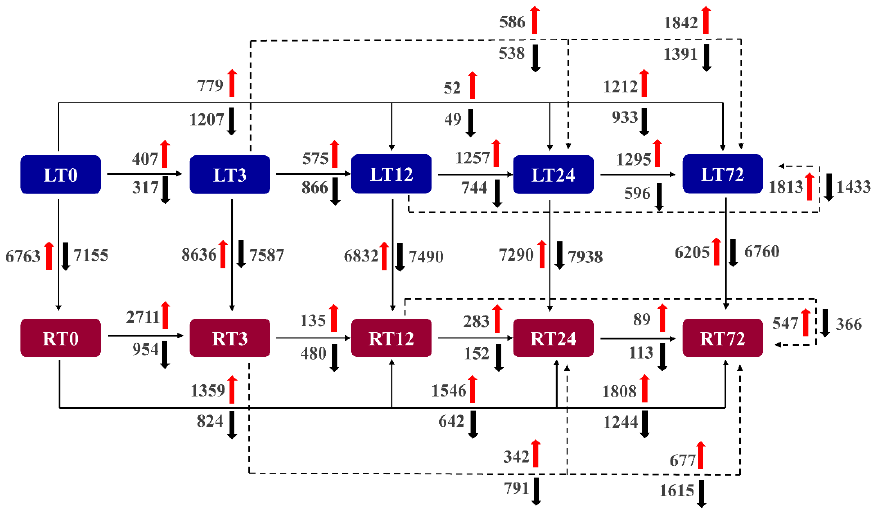
Figure 5. Summary of differentially expressed genes (DEGs) between organs and treatment dura-